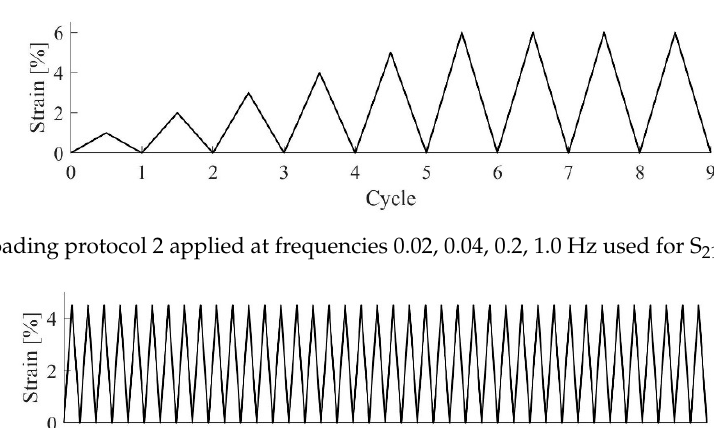
Figure 4. Loading protocol 1 (frequency 0.02 Hz) used for specimens S 11 to S 16 .